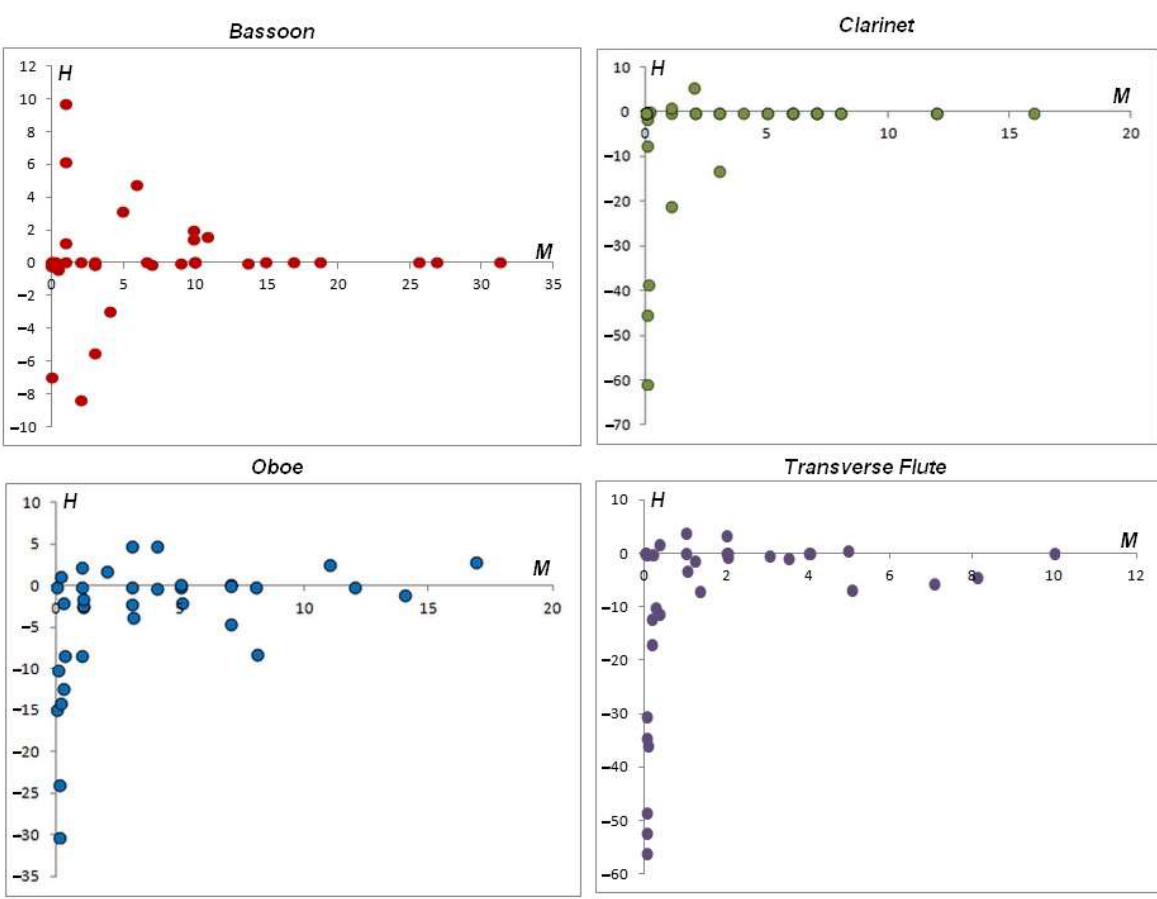
Figure 18. Two-dimensional representation in the MA – MC plane of the timbral space of coefficients for the selected aerophones.